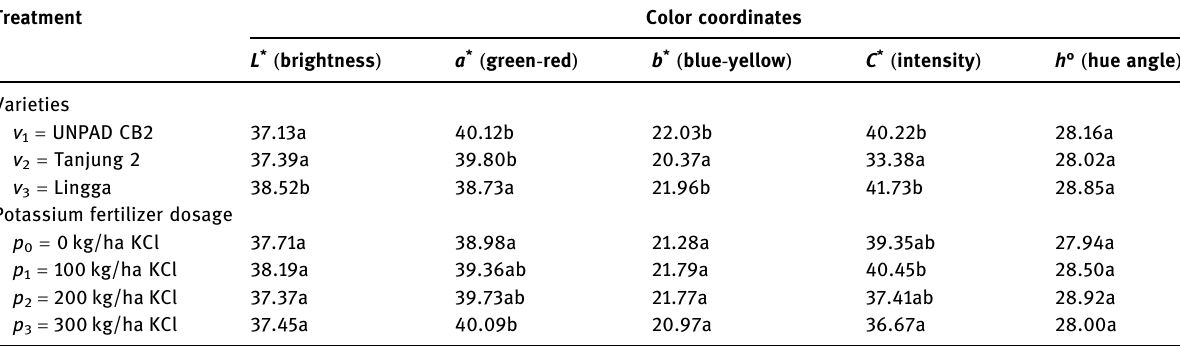
Table 7: E ff ect of variety and potassium fertilizer dosage on color coordinates L * , a * , b * , C * , and h °